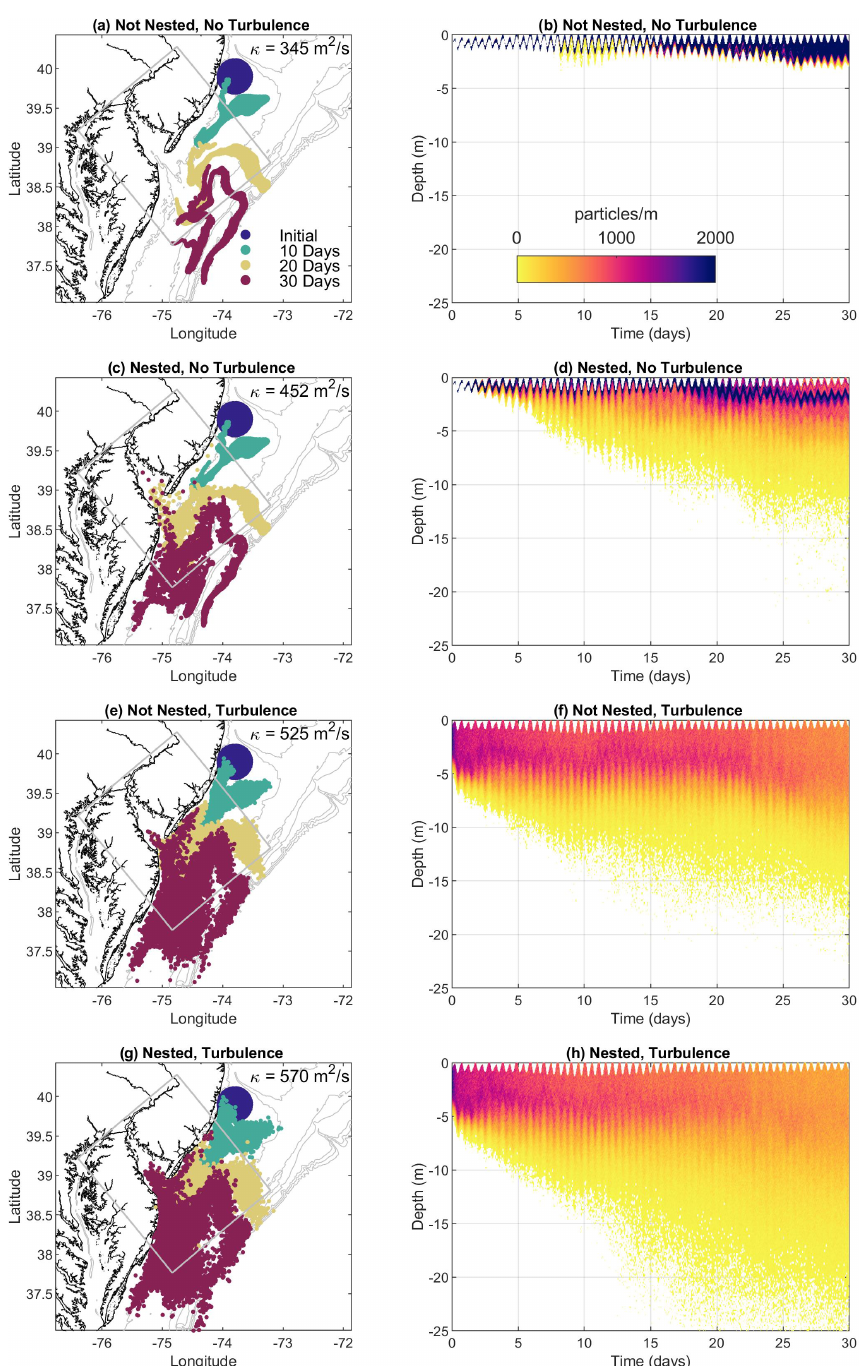
Figure 6. ROMSPath simulations showing particle locations ( a , c , e , and g ) after 10, 20, and 30d and vertical particle distributions ( b , d , f , and h ) over time. Panels (a) – (h) show ROMSPath runs with and without a nested grid and turbulence. The grey box in (a) , (c) , (e) , (g) is the boundary of the SnailDel domain. Diffusivity ( κ ) for each case is shown in the upper right of panels (a) , (c) , (e) , and (g) .